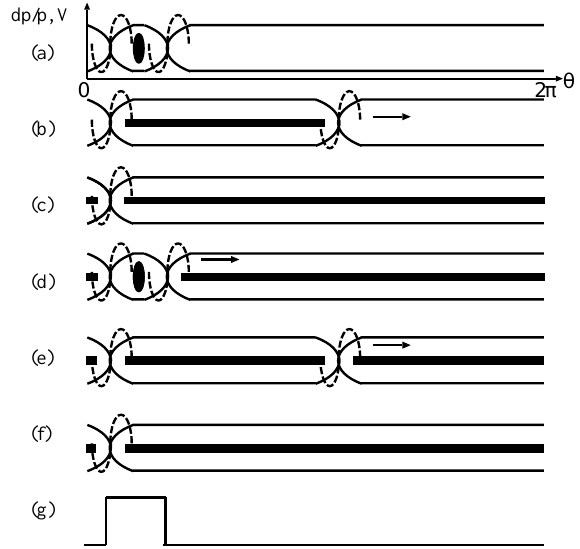
FIG. 1. Barrier bucket scheme. The horizontal and vertical coordinates are the rf phase and the momentum spread (solid line) or the rf voltage (dotted line), respectively. The upright ellipse means a bunch. The thick lines are the debunched beam; (g) is the injection kicker